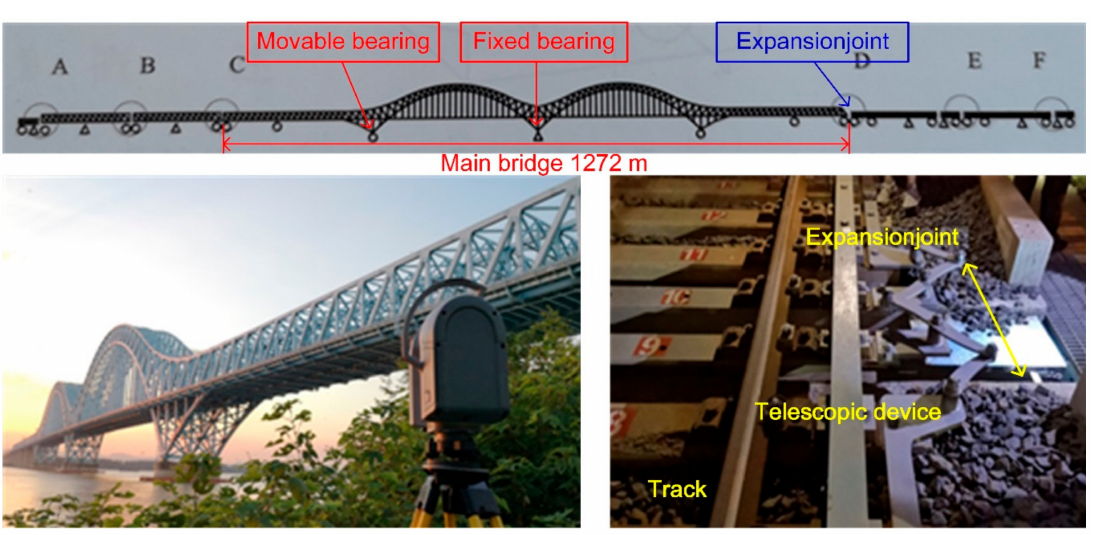
Figure 2. Layout (above) and view (below, left) of Nanjing–Dashengguan high-speed railway bridge (NDHRB). Below, right: telescopic device mounted at locations ‘C’ and ‘D’ shown in figure above.